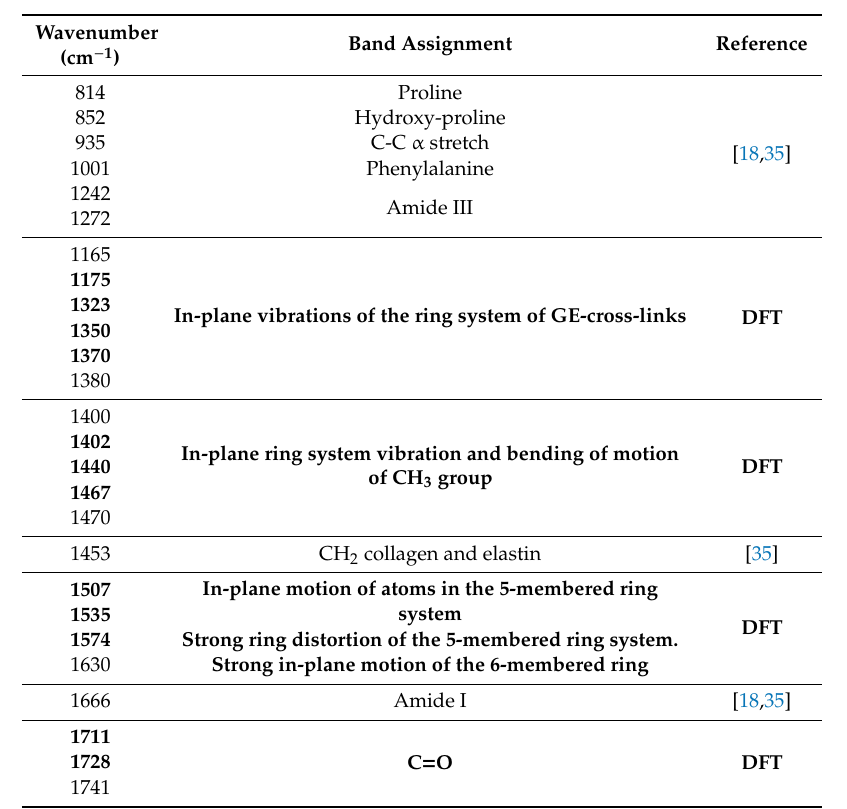
Figure 3. Raman spectra of untreated ARBP and GE cross-linked ARBP at 0.5 ( a ), 1 ( b ), and 2.5 h ( c ). Solid lines represent the mean and shaded areas represent the standard deviation of the Raman spectra (GE cross-linked N = 3, untreated ARBP N = 1). The prominent Raman bands are highlighted. Table 1. Band assignments for the Raman spectra detected in GE-ARBP (in bold) and untreated